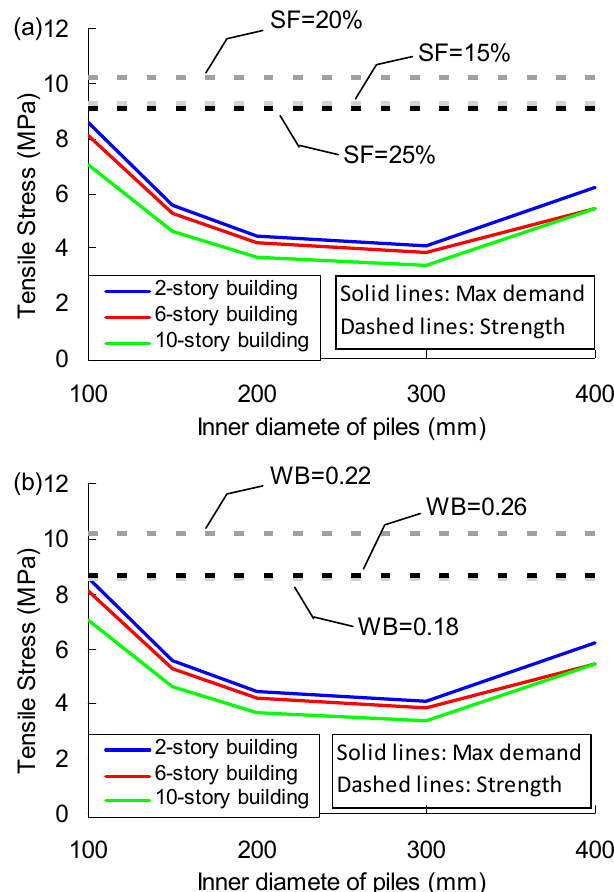
Figure 15. Test and simulation results comparisons: ( a ) different SF content; ( b ) different WB.